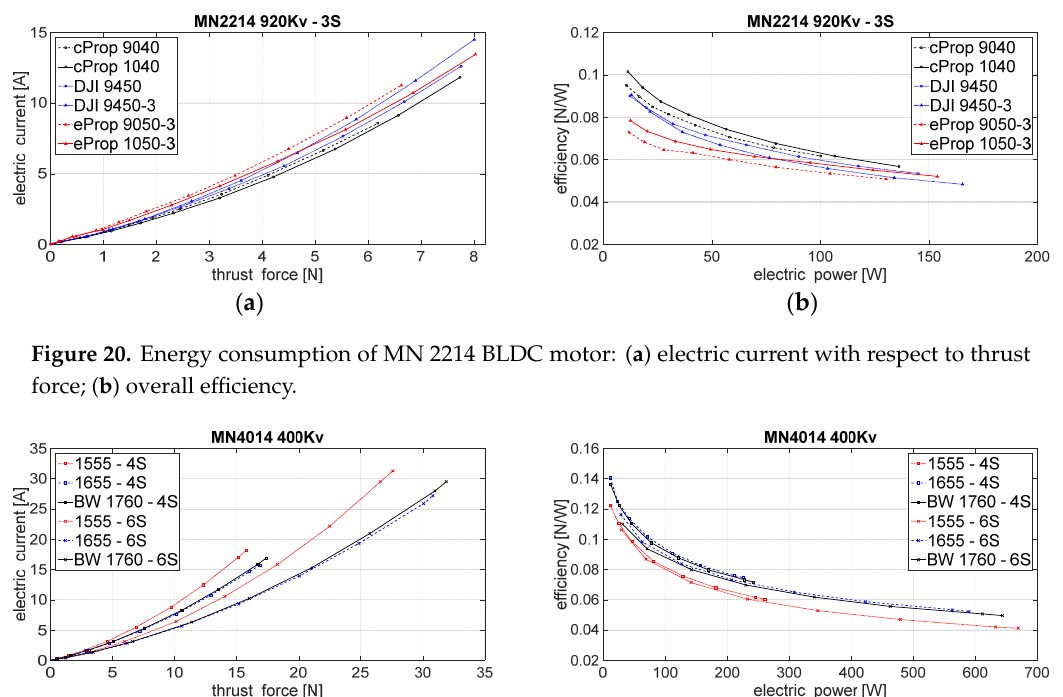
Figure 19. Energy consumption of 1806 BLDC series: ( a ) electric current with respect to thrust force; ( b ) overall efficiency.